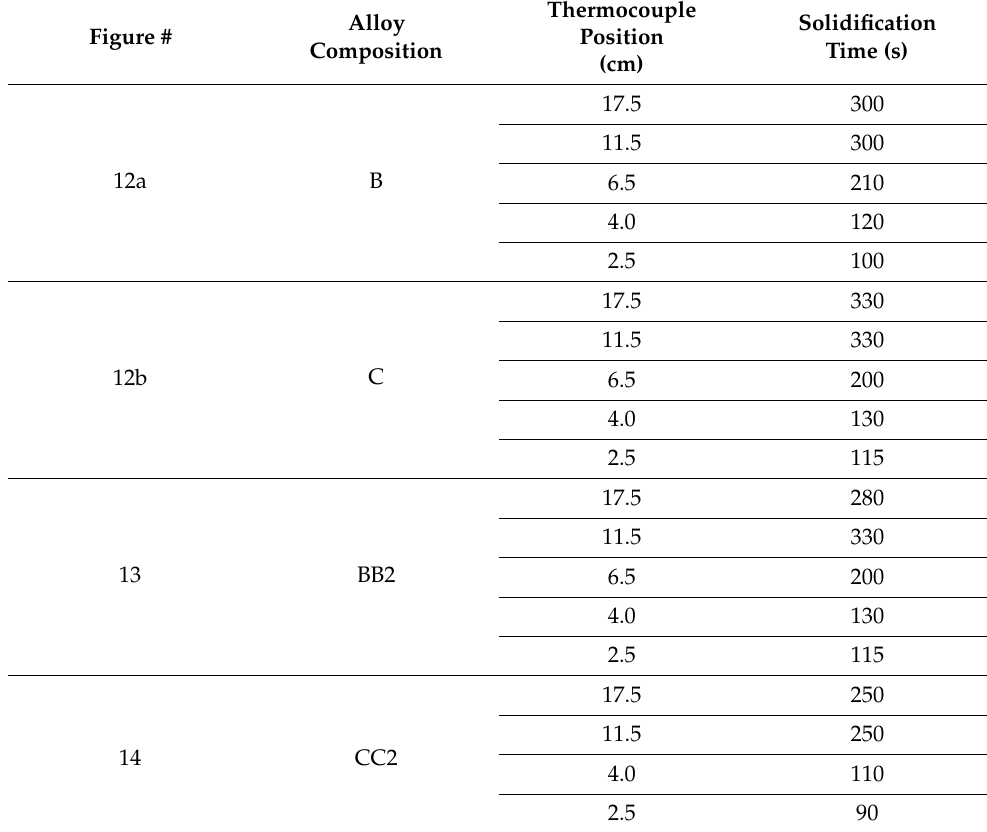
Table 5. Solidification time as a function of alloy composition and thermocouple position (large angle